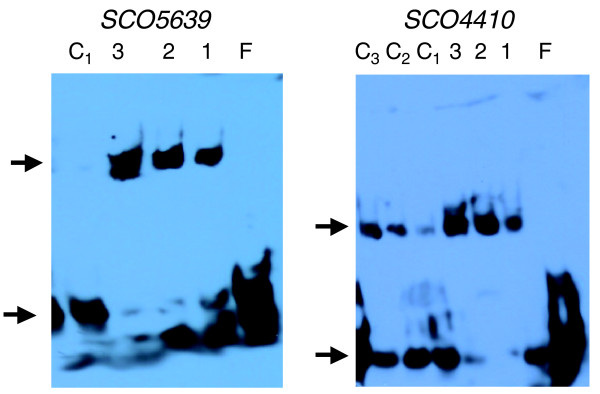
Gel-shift assays of putative new HspR targets: SCO5639 and SCO4410. HspR-binding at the SCO5639 and SCO4410 promoter regions. Oligonucleotide pairs are detailed in Materials and methods. Protein extract from E. coli over-expressing hspR was incubated with 200 fmol biotinylated DNA fragment without competitor DNA (lanes 1-3) with, respectively, 4, 6 and 12 μg cell extract. In the lane marked 'C1' in the SCO5639 gel shift, 4 μg cell extract and 200-fold molar excess of specific competitor DNA were loaded. In lanes C1-C3 in the SCO4410 gel shift, 4, 6 and 12 μg cell extract were loaded, respectively, together with 200-fold molar excess of specific competitor DNA. Lane F shows unbound DNA (no added protein). Arrows indicate positions of bound (upper arrows) and unbound double-stranded DNA target.